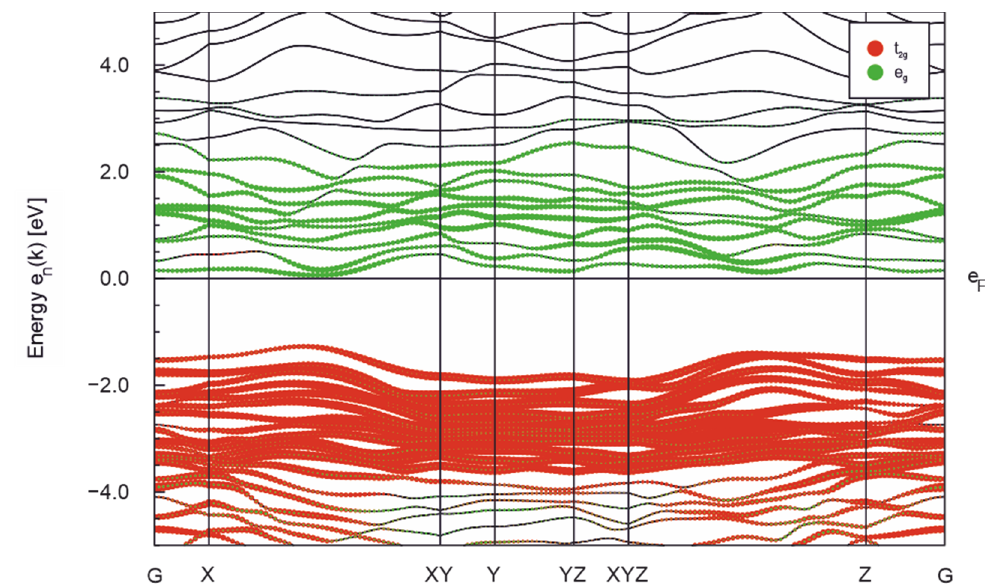
Figure 8. Electronic band structure of CaIr 4 S 8 with orbital projected representation of 5d iridium states.